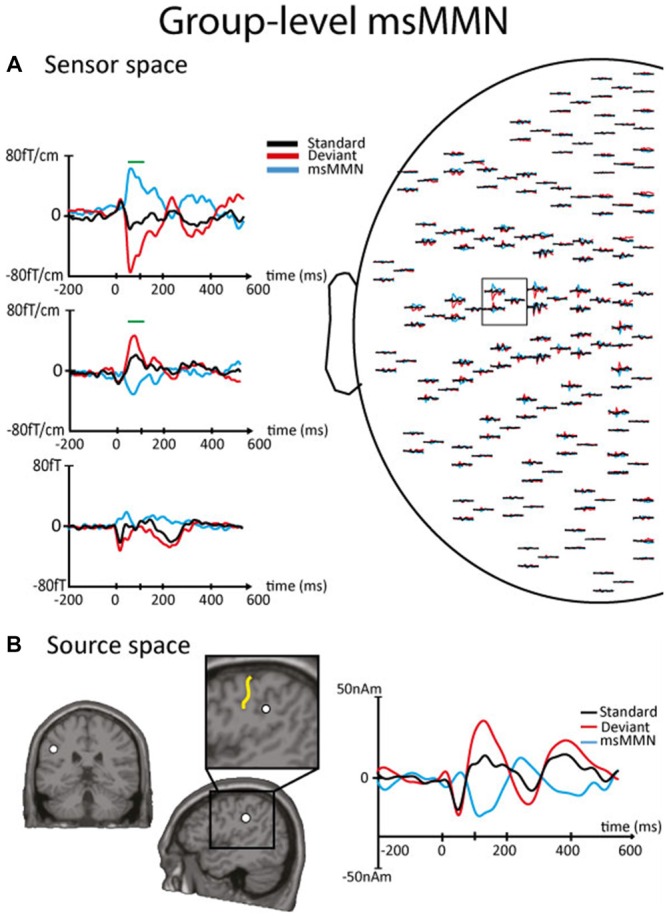
Results of the msMMN obtained in the sensor and the source spaces at the group level in session 1. (A) Right. Left part of the magnetoencephalography (MEG) sensor array viewed from top. Left. Enlarged orthogonal planar gradiometers (Top, Middle) and magnetometer (Bottom) signals showing evoked magnetic responses corresponding to standards (black line) and local deviants (red line). The blue line corresponds to the msMMN. Green lines indicate the timing of significant differences between standards and deviants disclosed by non-parametric cluster-based statistics performed at the sensor level. Of notice, in the sensor space, the polarity of the neural responses may appear different from sensor to sensor due to different spatial sensitivity (i.e., lead field) of orthogonal planar gradiometers and magnetometers to right beneath or nearby neural sources. (B) Left-Middle. Sagittal and coronal slices of the left hemisphere showing the location of the equivalent current dipole (ECD; white dot) that best explains the magnetic field pattern at the msMMN maximum amplitude. The enlarged area of the sagittal slice shows that the ECD is located at the posterior bank of the left postcentral sulcus, i.e., at the rostroventral part of the left inferior parietal lobule. The central sulcus is indicated by the yellow line. Right. Source waveforms corresponding to standards (black line) and local deviants (red line). The msMMN (blue line) shows a negative deflection.